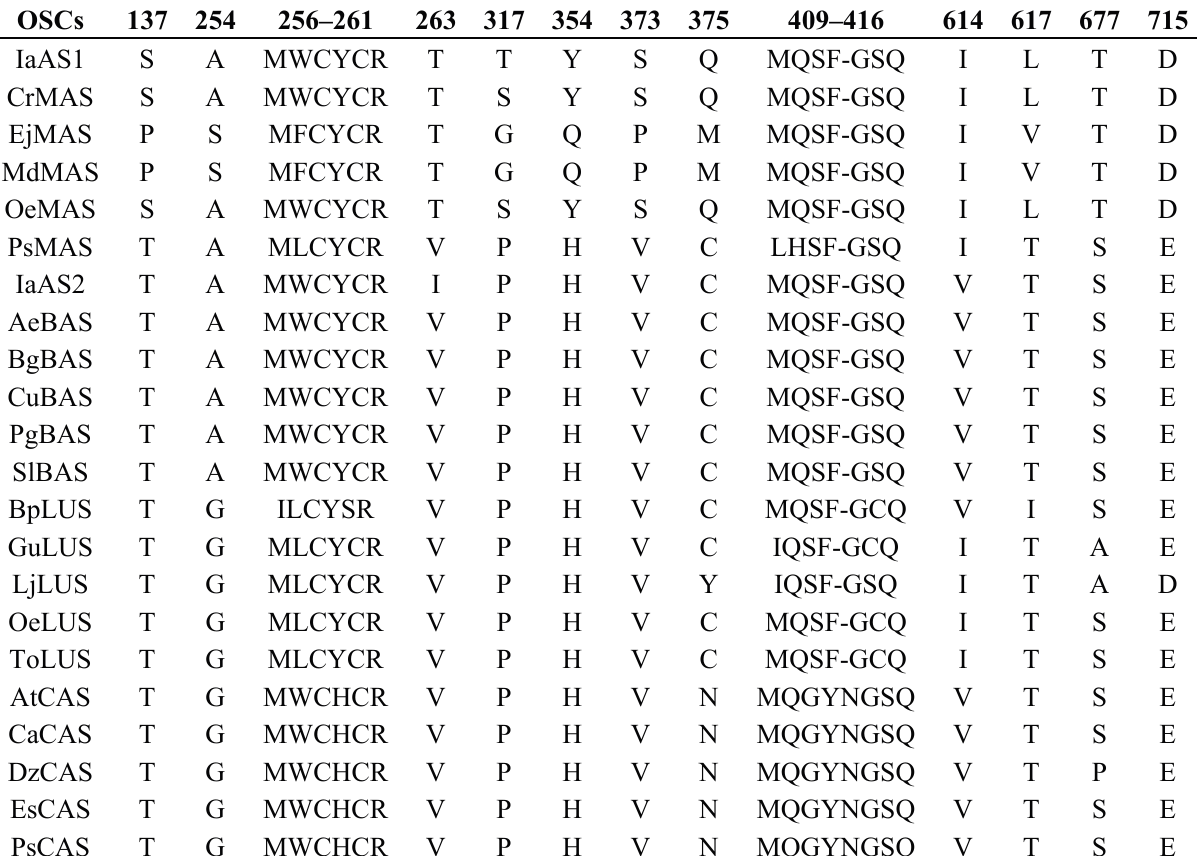
Table 1. Comparison of special sites in the amino acid sequences of 22 known